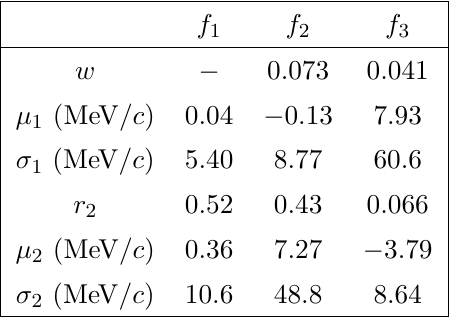
Table 1 . Parameters of the momentum resolution functions of eq.